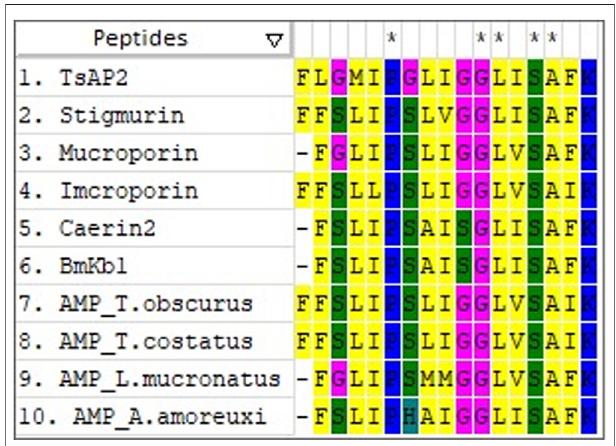
FIGURE 1 | Sequence alignment of 10 scorpion antimicrobial peptides. *Conserved